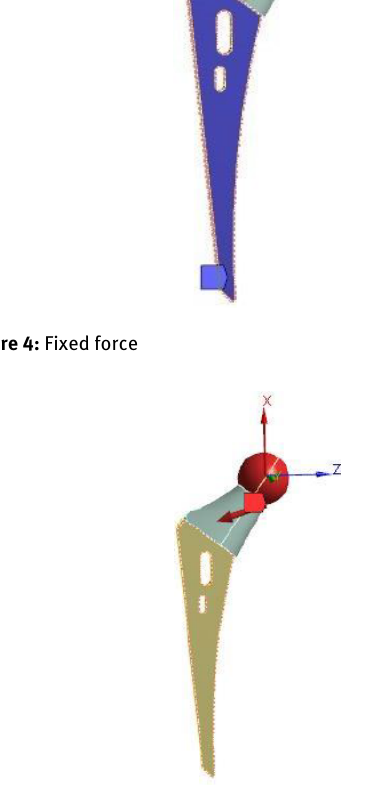
All models were set to the same boundary conditions.